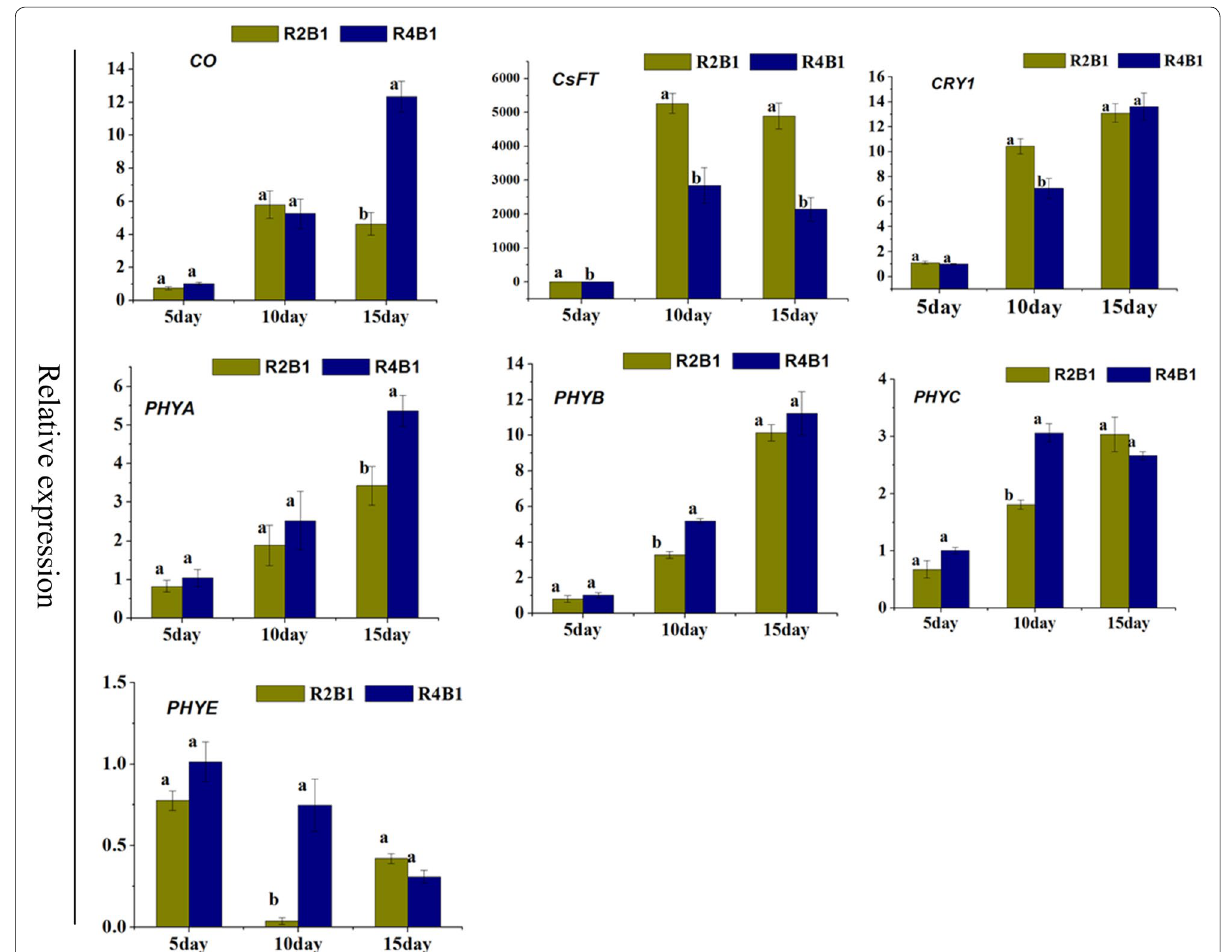
Fig. 7 The expression of a number of flowering and light signal transduction related genes were altered in cucumber seedlings leaves under different light quality treatments. Error bars represented standard deviations of the means of three independent replicates. Statistically significant variations of expression and mean values at different sampling points (ANOVA, p < 0.05) were indicated with different